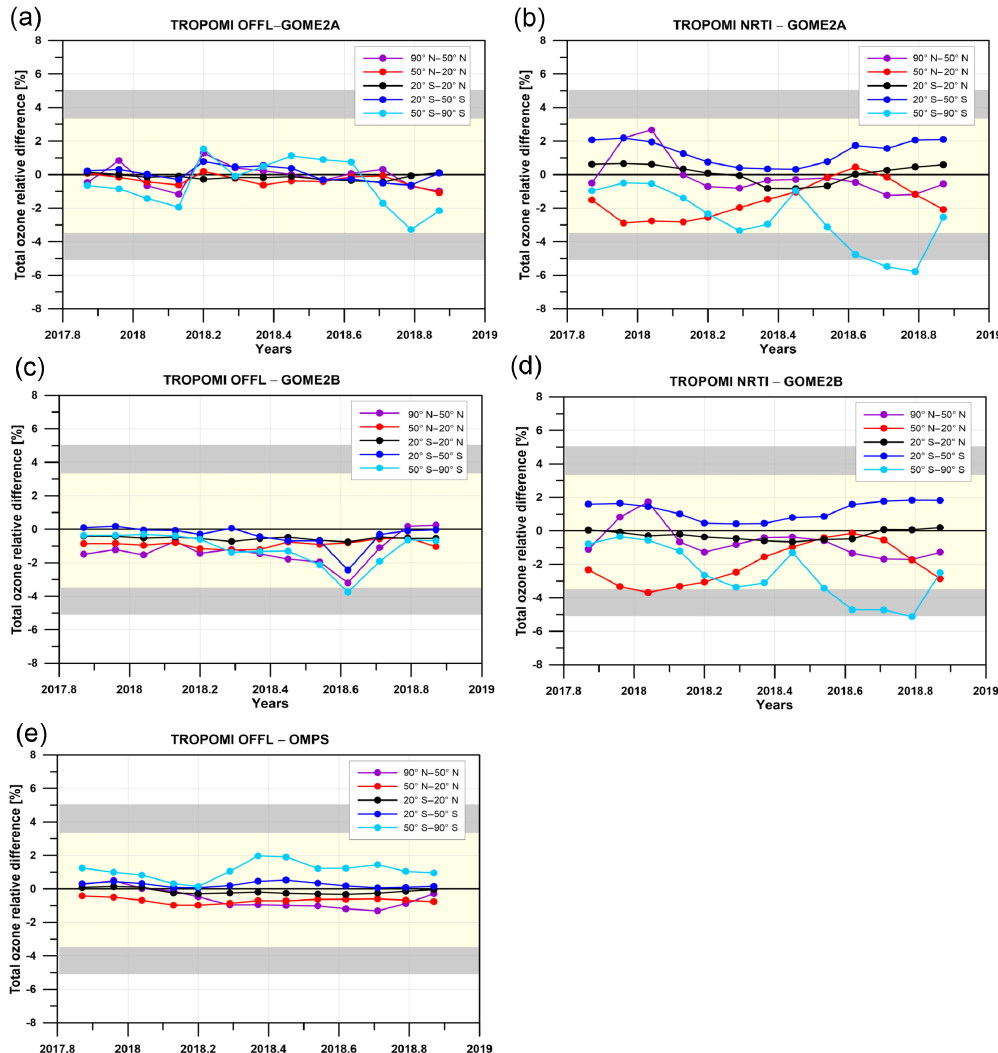
Figure 17. The time series of the percentage differences between TROPOMI and GOME2A, GOME2B and OMPS TOCs, for five latitude belts: 90–50 ◦ N (purple line and dots), 50–20 ◦ N (red line and dots), 20 ◦ N–20 ◦ S (black line and dots), 20–50 ◦ S (blue line and dots), 50–90 ◦ S (cyan line and dots). In the left column, the TROPOMI OFFL TOC is compared to GOME2A (a) , GOME2B (c) and OMPS (e) processed with GODFIT v4. In the right column, the NRTI TOC product of TROPOMI is compared to GOME2A (b) and GOME2B (d) processed with GDP